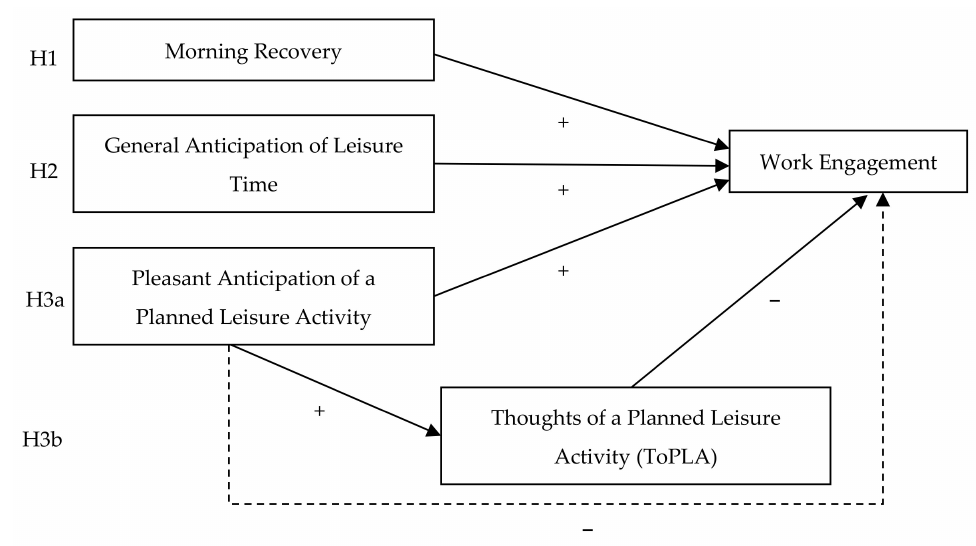
Figure 1. Research model. The dotted line represents the indirect effect through